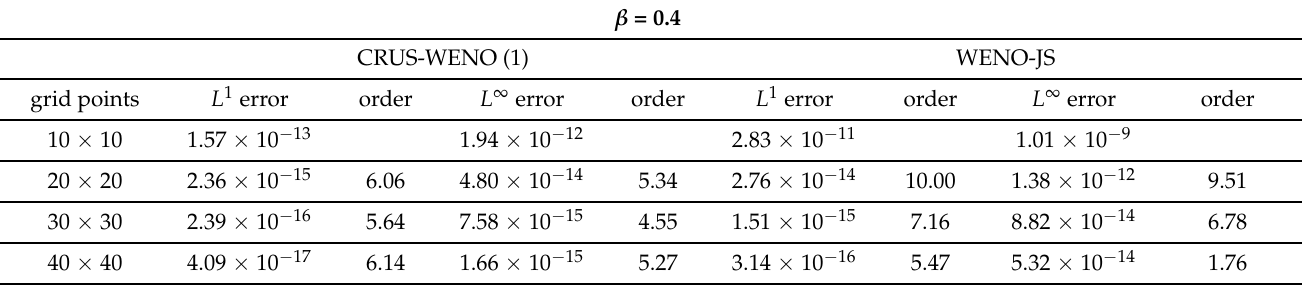
Table 3. The errors and orders of the accuracy of Example 3 at t = 0.1. β =